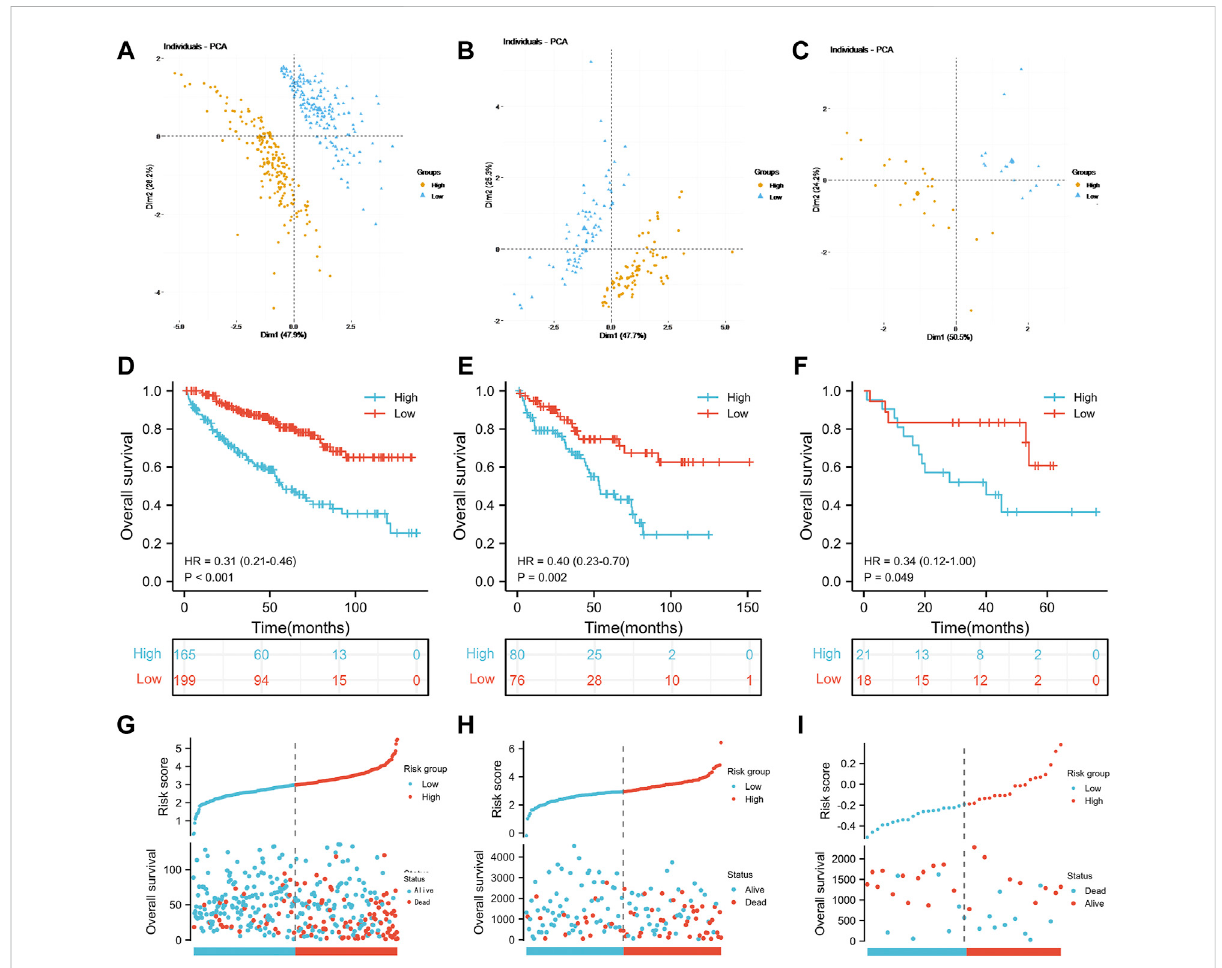
FIGURE 3 Prognosticperformance of thein fl ammation-relatedsignature:Principal component analysisresults oftheTCGA training group (A) ,TCGA test (B) and GSE29609 (C) . Kaplan-Meier analysis results of the TCGA training group (D) , TCGA test (E) and GSE29609 (F) . The risk score plots of TCGA training group (G) , TCGA test (H) and GSE29609 (I)